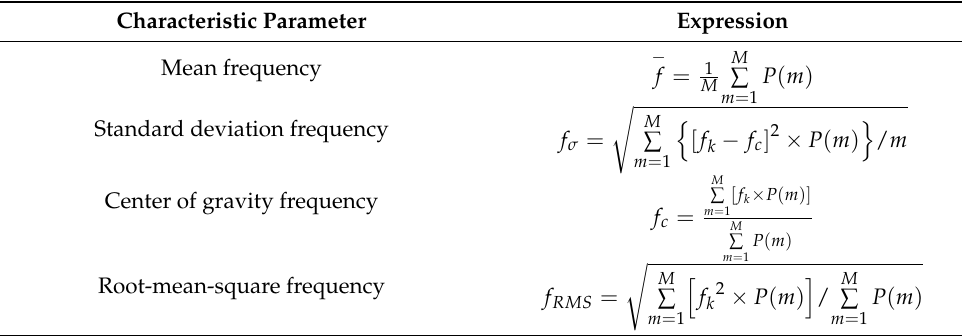
Table 3. The frequency-domain characteristic parameters. Characteristic Parameter Characteristic